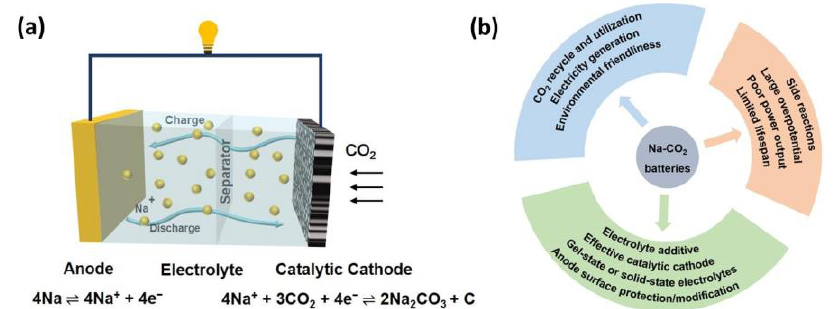
Figure 1 . ( a ) The schematic configuration of rechargeable Na-CO 2 batteries; ( b ) The importance, existing challenges, and potential solutions for Na-CO 2 batteries.